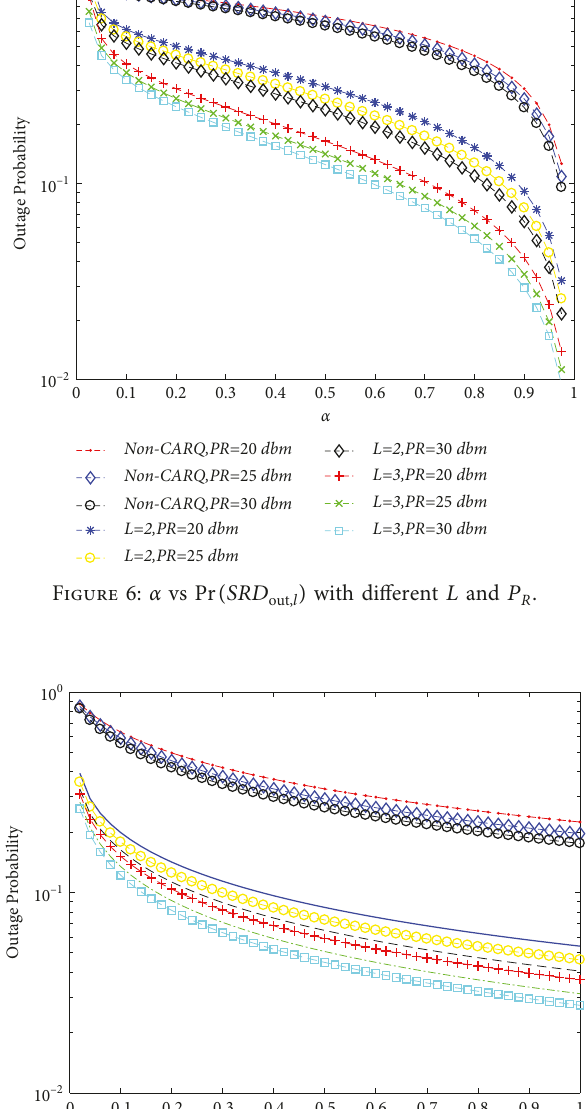
SRD out ,l ) with different (